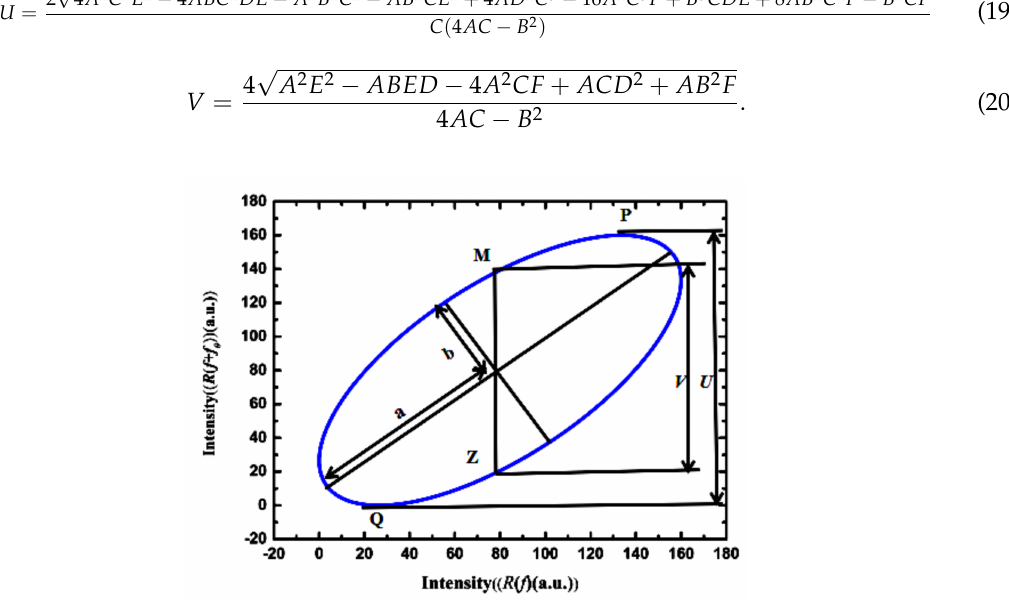
Figure 2. Lissajous figure obtained from the reflection spectrum and its translation in the frequency